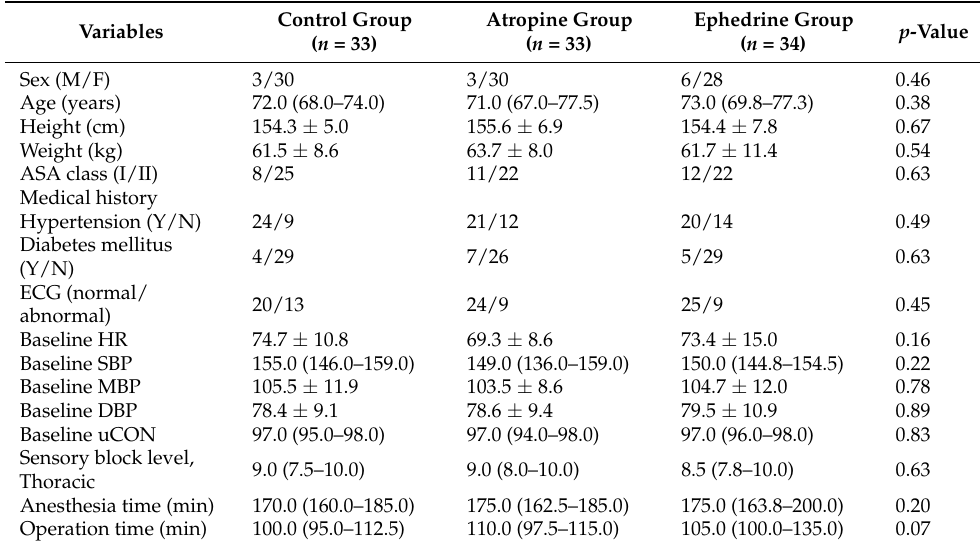
Table 1. Patient characteristics and clinical data.